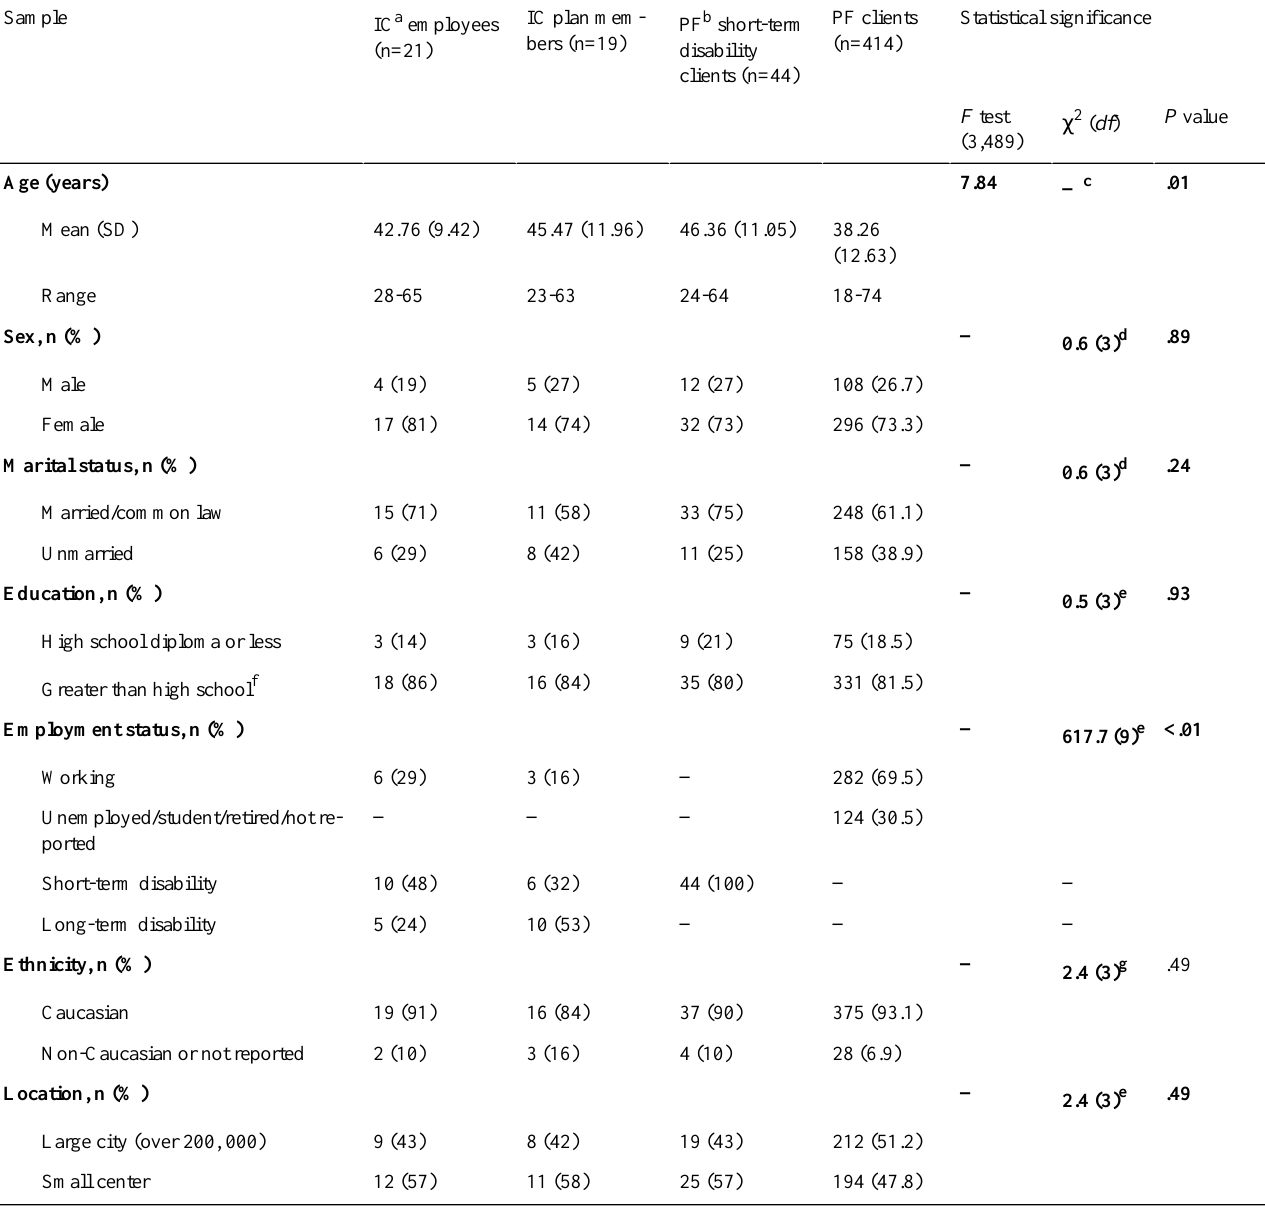
Table 1. Demographic characteristics of clients separated by